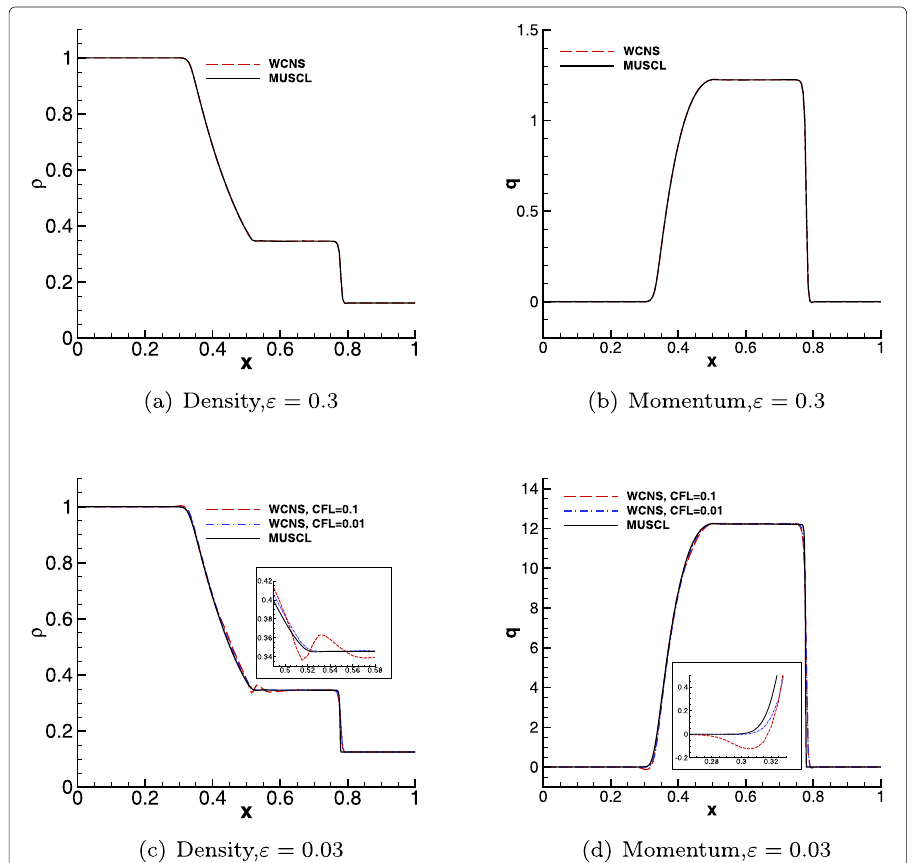
Fig. 2 Example 3. Density (left) and momentum (right) calculated by the GSA IMEX-ARS3 WCNS with N = 200 cells and the GSA IMEX-ARS3 MUSCL with N = 2000 cells at t = 0.05 for ε = 0.3 and at t = 0.005 for ε = 0.03. The values of the Mach number are ε = 0.3 (top) and 0.03 (bottom). a Density, ε = 0.3. b Momentum, ε = 0.3. c Density, ε = 0.03. d Momentum, ε = 0.03